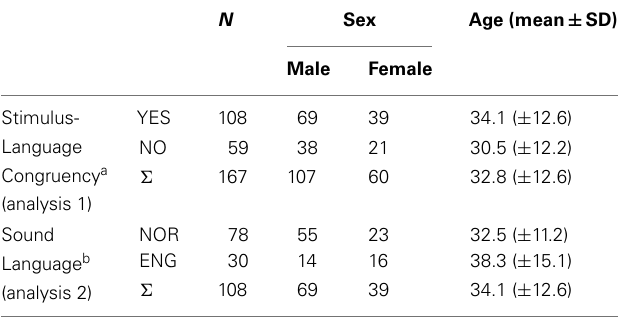
Table 1 | Sample characteristics Experiment